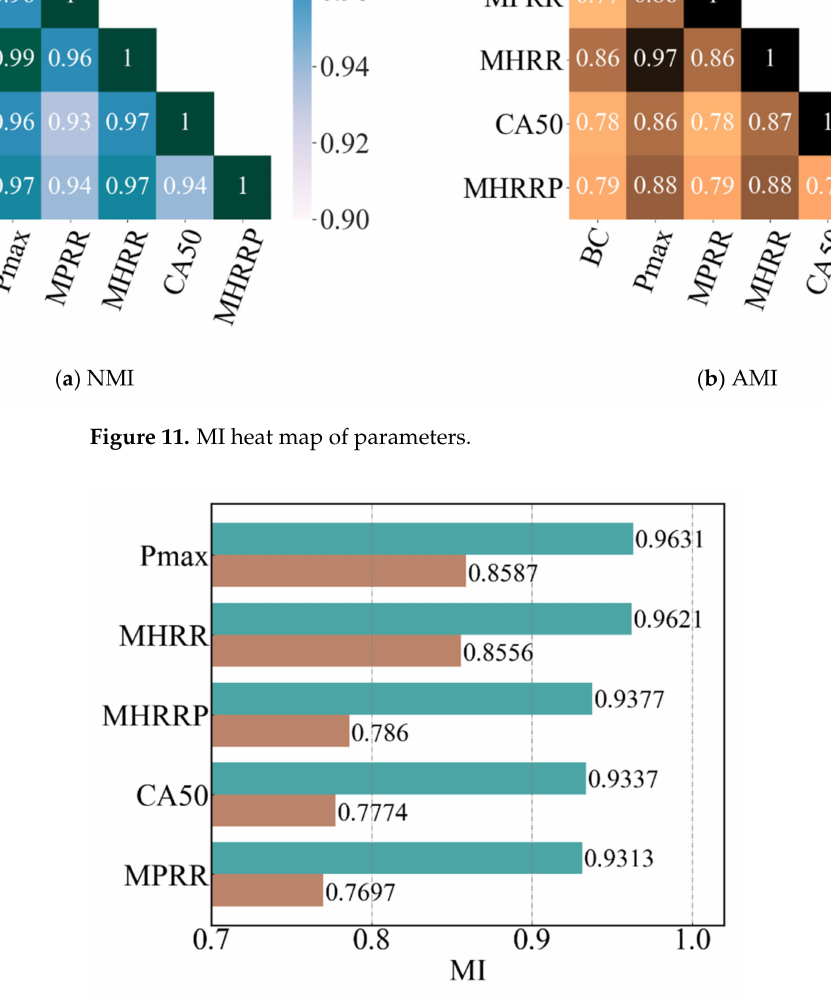
Figure 12. MI of CCPs and BC